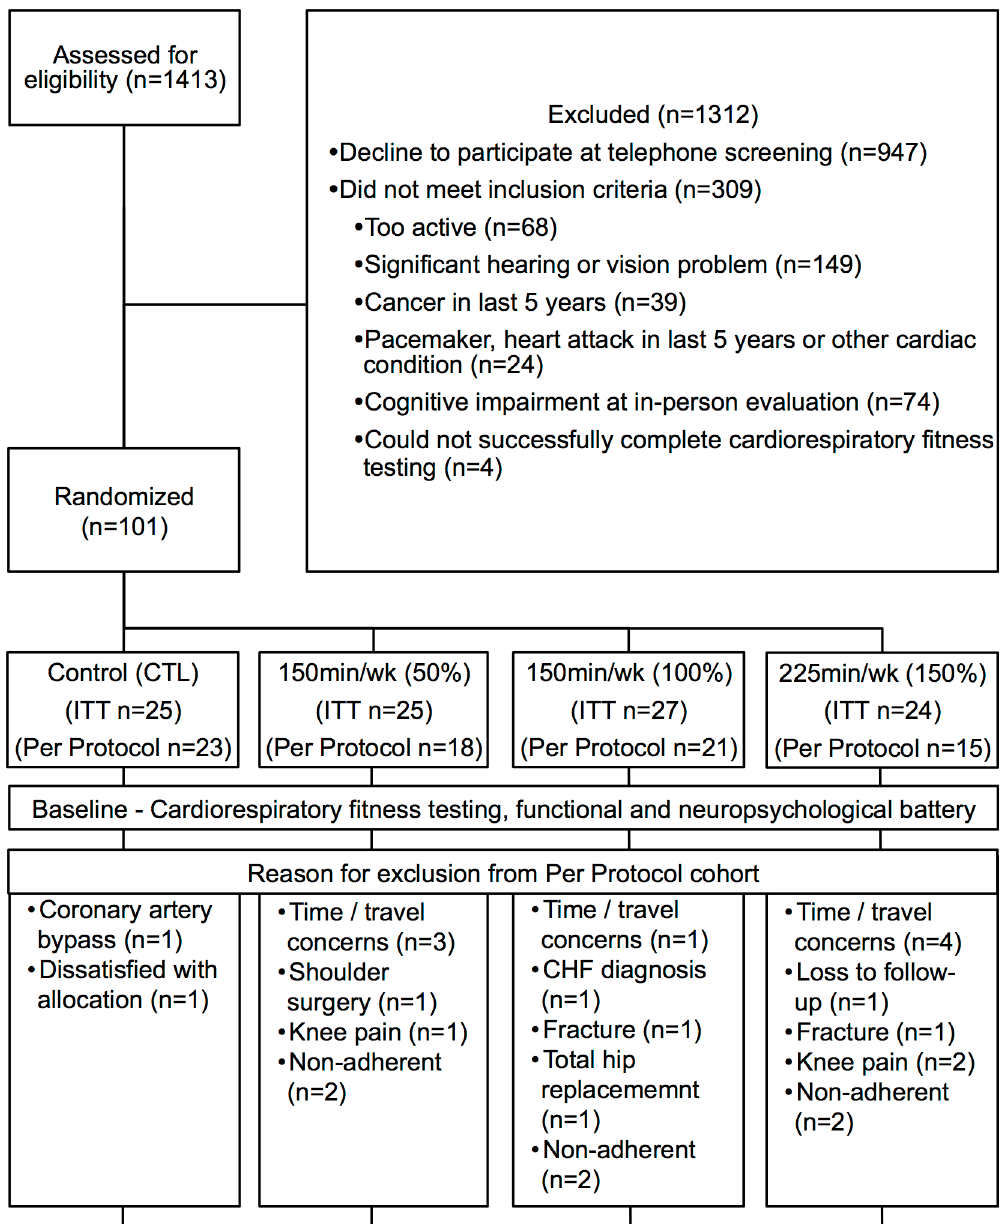
Fig 1. Study enrollment flow. Baseline measures of enrolled participants are provided in Table 1. Of the intent-to-treat (ITT) cohort (n = 101), 8 individuals withdrew due to time or travel concerns, 8 withdrew due to medical issues, 1 was dissatisfied with his group allocation, and 1 was lost to follow-up. Another 6 individuals were non-adherent to the exercise prescription. Those who did not adhere had slightly more education (17.8yrs [3.2] vs 16.1yrs [2.4]) otherwise there were no significant differences. The remaining 77 individuals were included in per-protocol (PP) analyses: control (n = 23), 75min/wk (n = 18), 150min/ wk (n = 21), and 225min/wk (n =